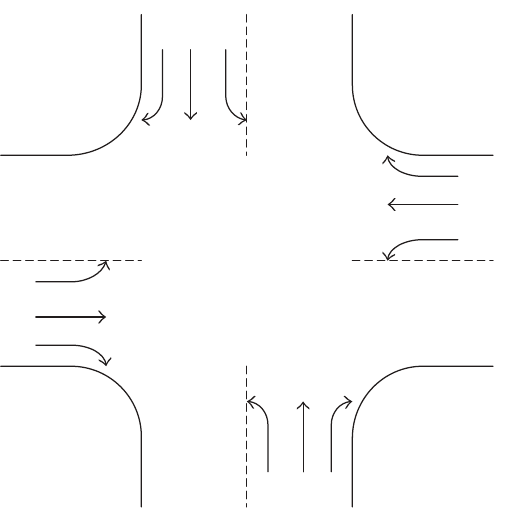
Figure 1: The typical intersection with four phases.